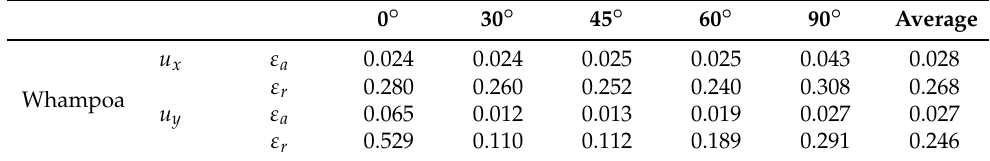
Table A7. Absolute and relative errors for the homogeneous neighbourhood (Whampoa) and the optimal arrangement of vortex sheets ( Ω bestx for u x and Ω besty for u y ; Equations (9a) and (10a)).